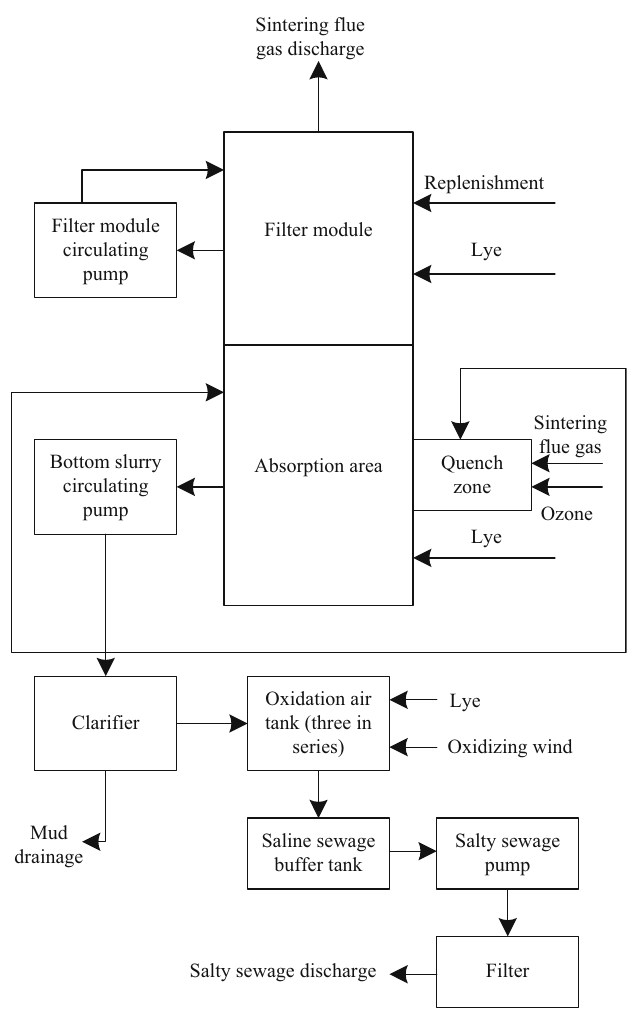
Figure 2: Brief process fl ow of sintering fl ue gas deep desulfurization system in iron and steel